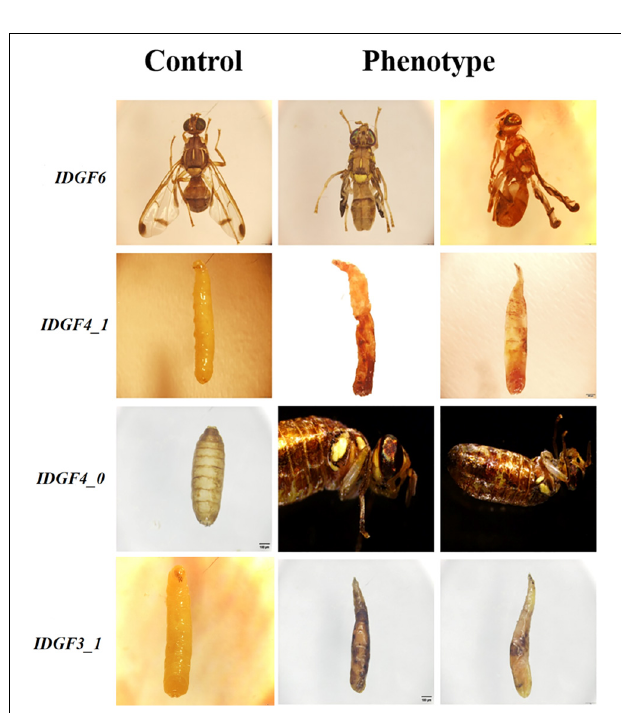
FIGURE 6 | Phenotypes, abnormalities after feeding dsRNA of IDGFs compared to control group dsGFP or DEPC in different developmental stages of Z. cucurbitae . All Pictures were taken with a scale bar 200 µ m. The Control group represents either dsGFP or DEPC, and the Phenotype group represents abnormalities post feeding dsRNA for each gene. In phenotypes groups IDGF6 represents wings malformation in Z. cucurbitae, IDGF3_1 and IDGF4_1 represents larval lethal phenotypes and IDGF4_0 represents phenotype at pupal–adult stage where flies fail to shed their old cuticle.